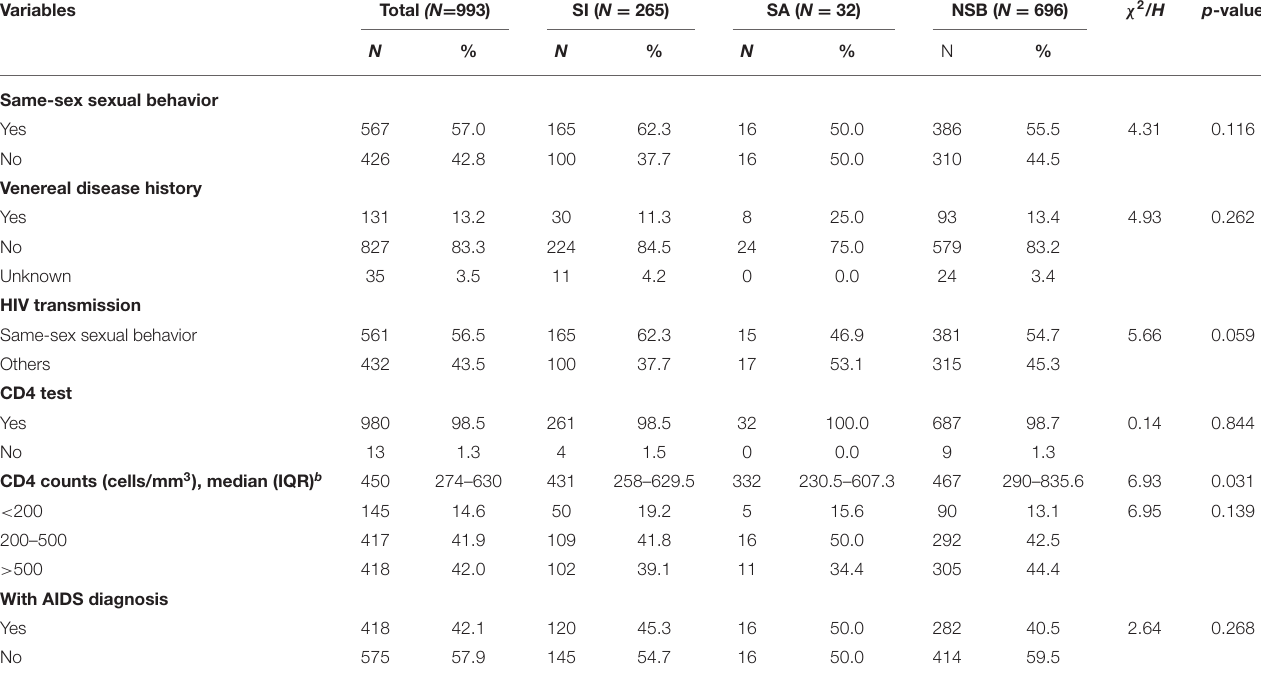
TABLE 2 | HIV-related clinical features of total samples, SI, SA, and NSB groups of PLWH a . Variables